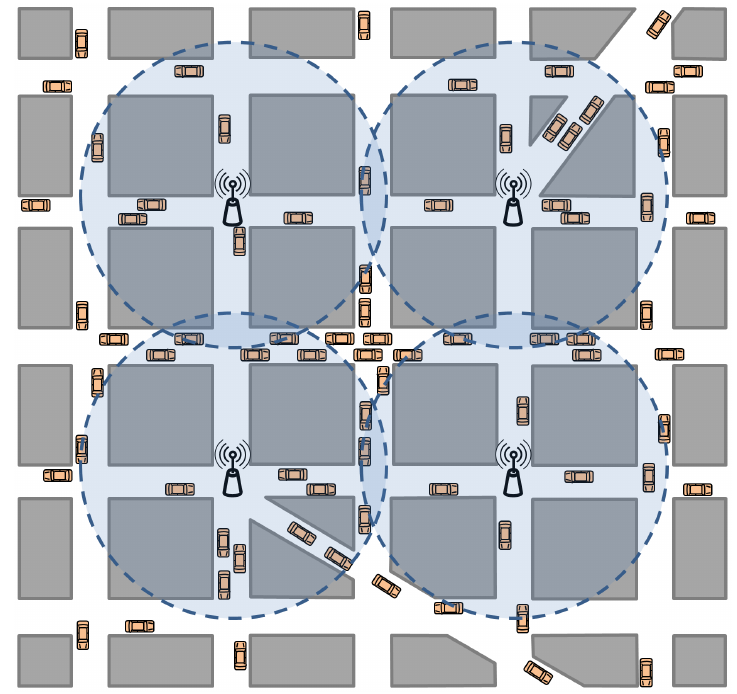
Figure 2. Example of blind spots due to insufficient RSU